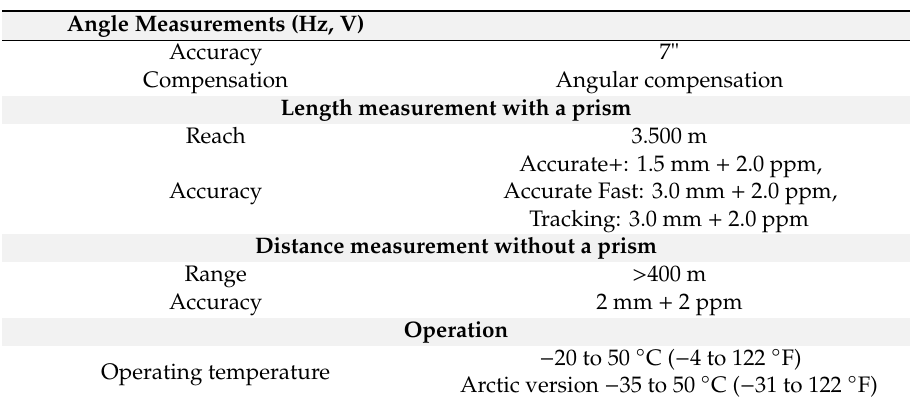
Table 1. Leica TS02 characteristics.